Question: Sum up the contents of this chart in one sentence.
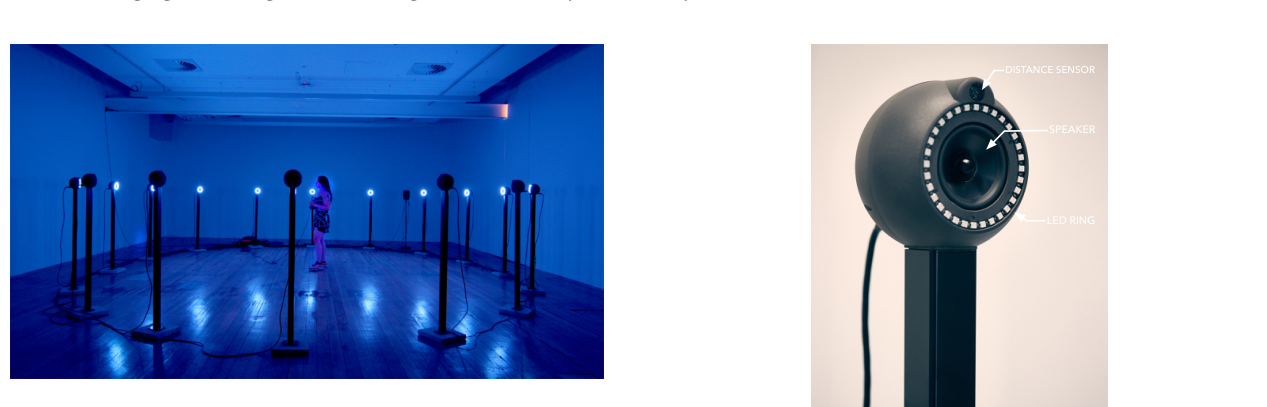
Answer: Excerpt from the live performance showing the uniformity in the hardware design of the virtual singers along with the position of the human performer.